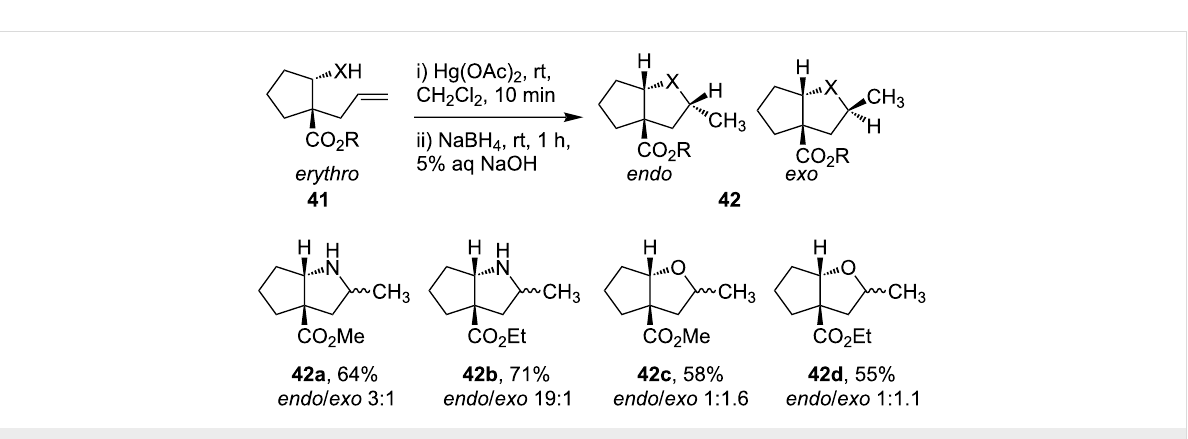
Scheme 16: Hg(OAc) 2 -mediated 2-aza- or 2-oxa-bicyclic ring